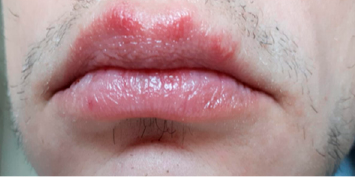
Figure 4. Oral mucosa ulceration on the inferior lip affecting a 16-year-old girl.